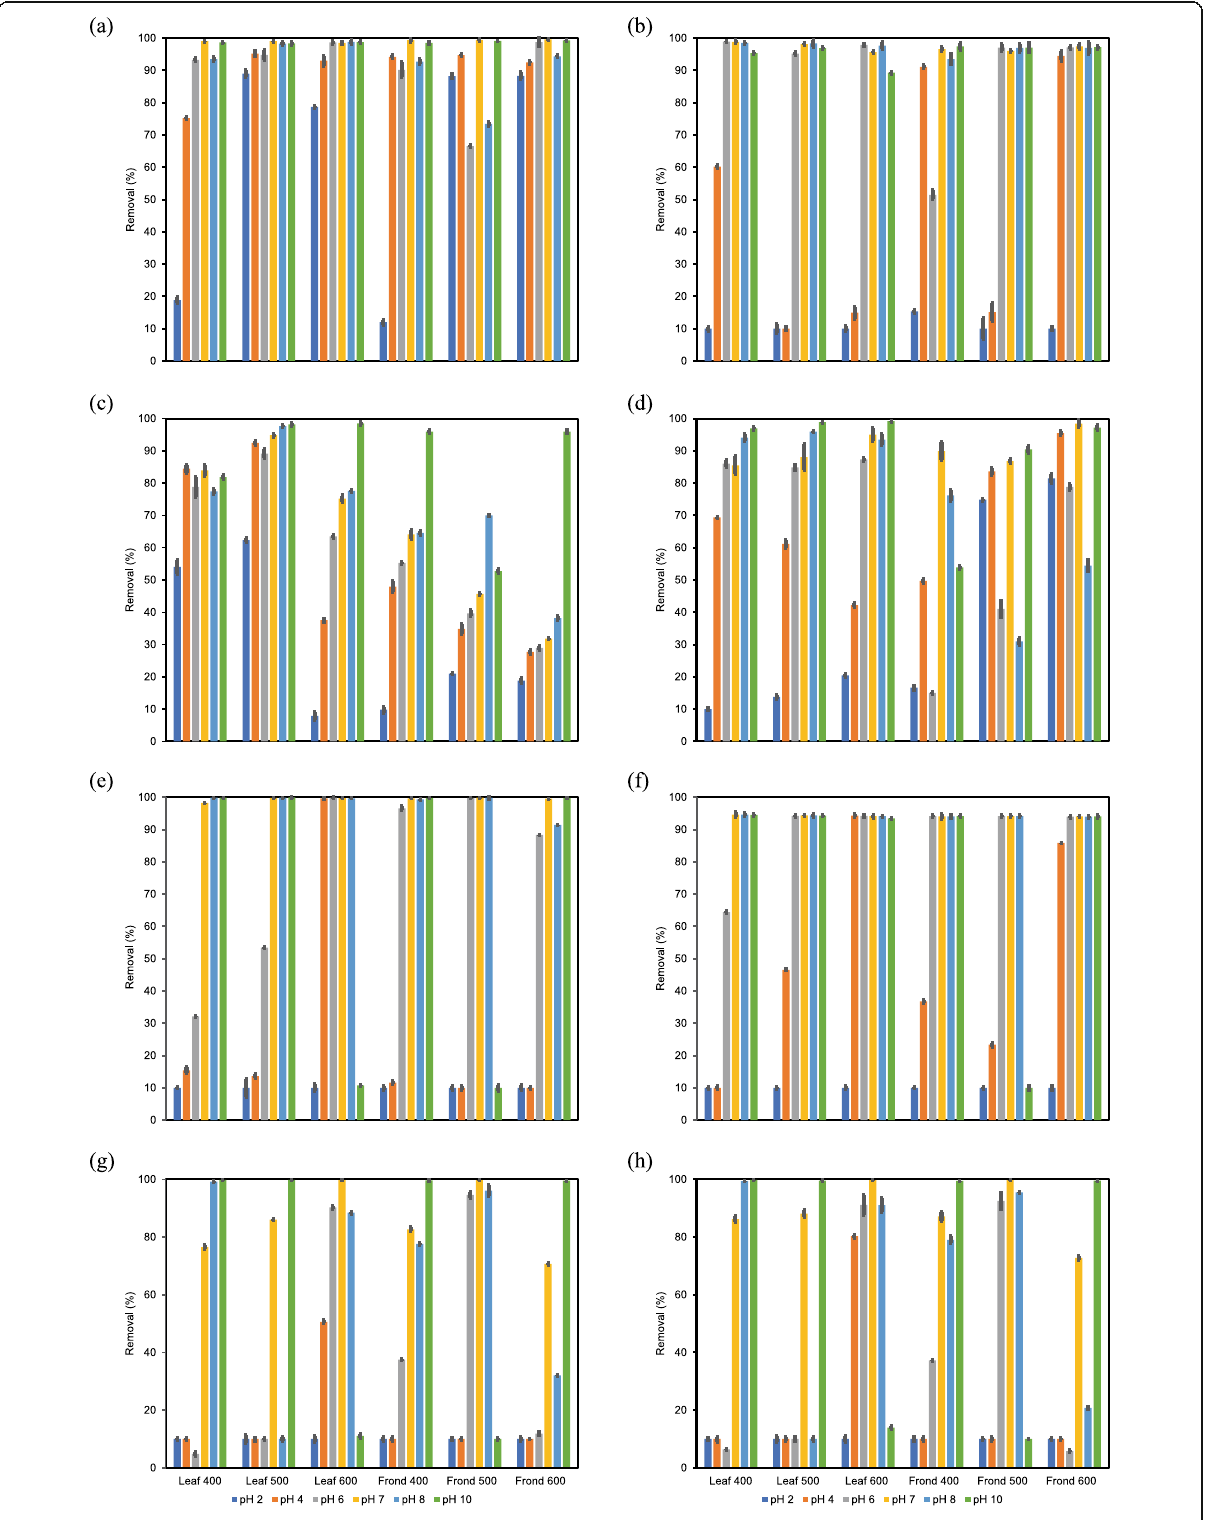
Fig. 6 The removal efficiencies of a copper, b iron, c nickel, d zinc, in single metal solutions and e copper f iron, g nickel and h zinc in mixed metal solution by biochar